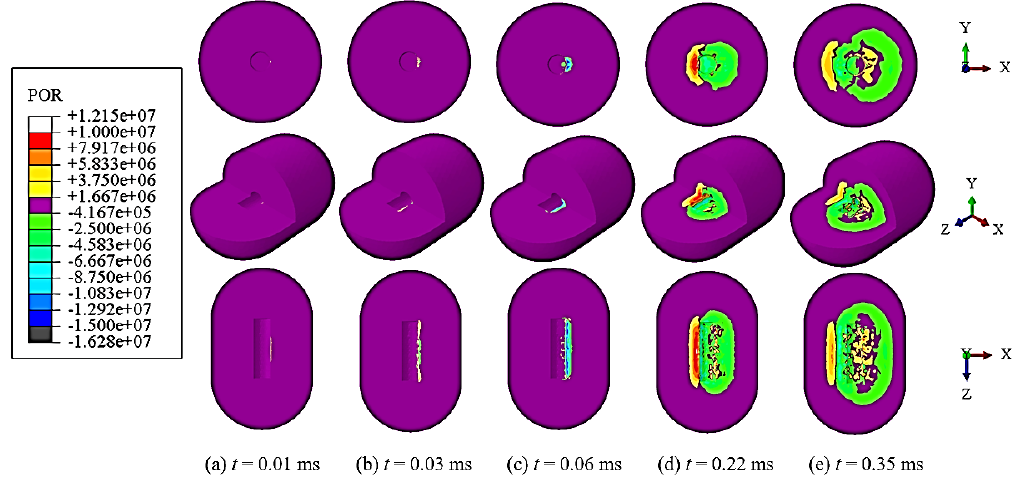
Figure 7. Pressure diagram of three-dimensional flow field.